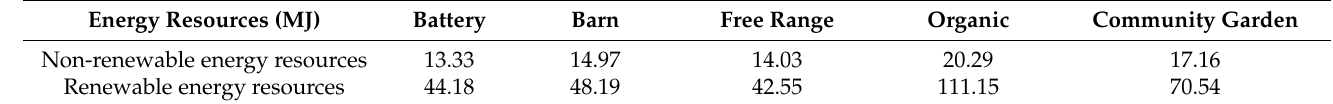
Table 5. Results per impact categories for the production of one kilogram of eggs per laying system in the Czech Republic using Environmental Footprint 3.0.